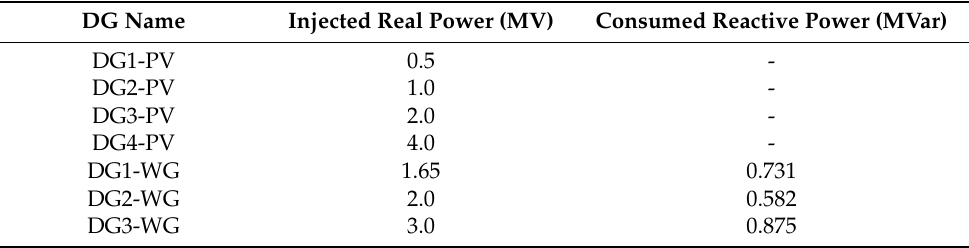
Table 3. The sizes of the distributed generation (DG) units used in the simulations [21].